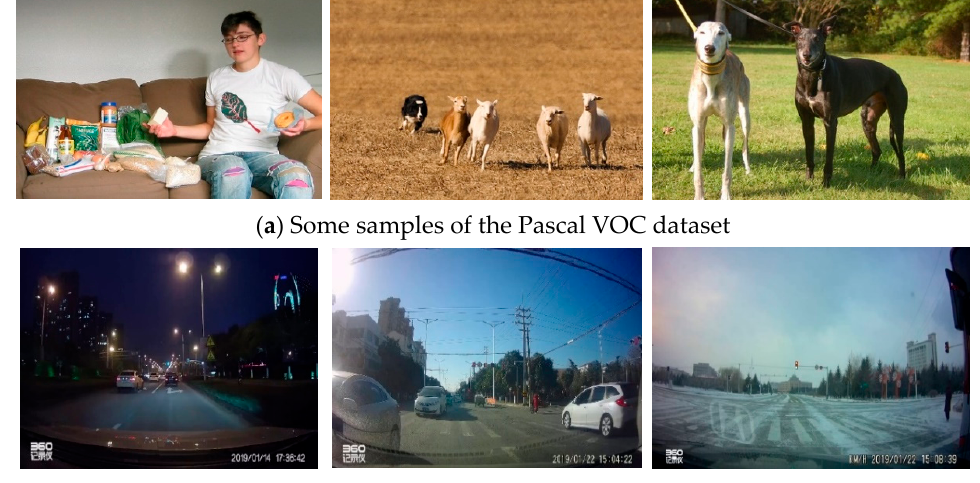
Figure 6. Improved network TSR-YOLO.